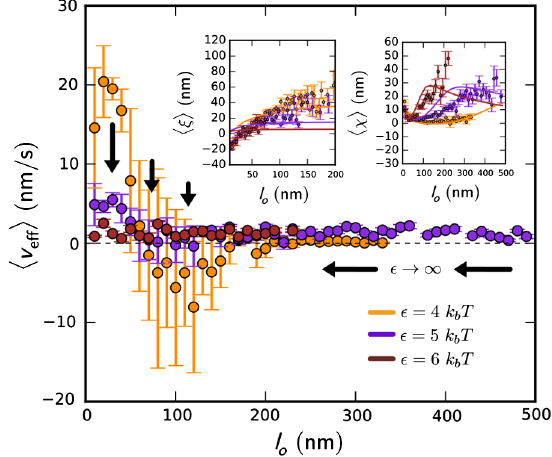
FIG. 6. Effective interfilament velocity in the one-dimensional ¼ active force dipole as a function of pairwise overlap, with k cl u 10 = s against K ¼ 0 . 01 pN = nm tethers. This plot can be inter- t preted as the contractile force-velocity relation of the structural element, since pairwise filament overlap l is directly propor- o tional to the restoring force on filaments due to external tethers. The effective interfilament velocity of the dipole (i.e., the rate at which filament overlap increases) is calculated by combining the change in overlap and frequency of contraction and extension ð l Þ ¼ χ ð l Þ ω ð l Þ − ξ ð l Þ ω ð l Þ . Cross-linking in an events: V χ ξ o o o o o eff optimal range amplifies forces produced by the dipole and is apparent in the effective contractile velocity of the filament pair at Þ and ξ ð l Þ are also shown in the inset. large overlaps. χ ð l o o Analytic approximations for the expected value of these events are showed as filled